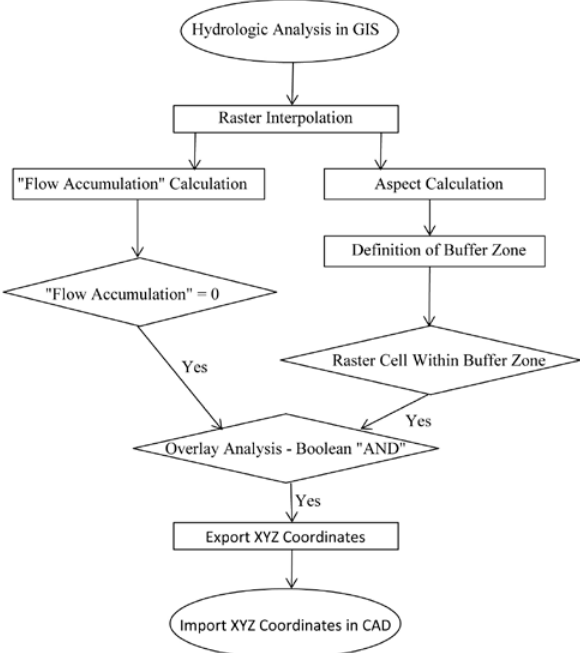
Figure 2. Flowchart of hydrologic analysis in